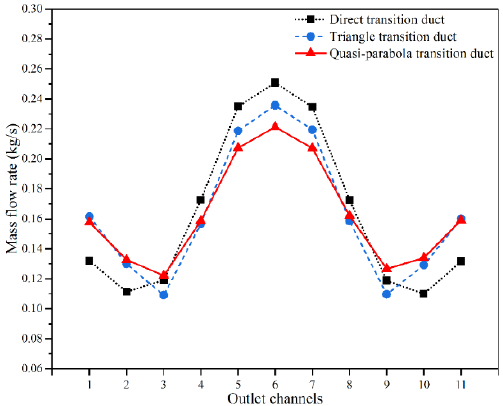
Figure 8. Comparison of mass flow rates at outlet channels and flow maldistribution degree.